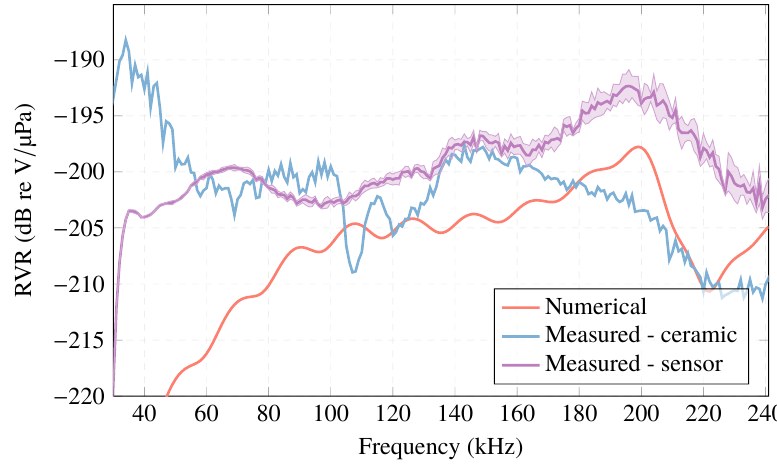
Figure 14. Simulated and measured RVR for ceramic and sensor in water.